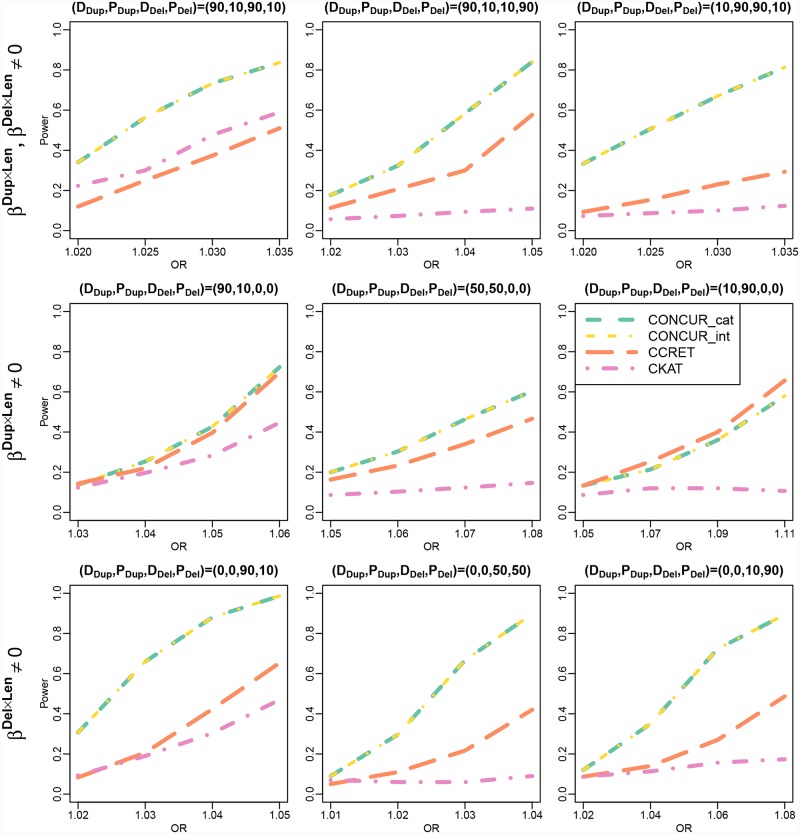
Power comparison between CONCUR, CCRET, and CKAT in the TGP-Chr1(a) simulations (causal dosage × length effects in chromosome 1 of TGP data).The top panel shows power under combined duplication and deletion effects, the middle panel shows power under effects from duplications only, and the bottom panel shows power under effects from deletions only. Different proportions of deleterious vs. protective effects are considered as indicated by (DDup,PDup,DDel,PDel) with DDup and PDup reflecting the proportions of deleterious and protective segments among causal duplication segments, and with DDel and PDel defined similarly for causal deletion segments.